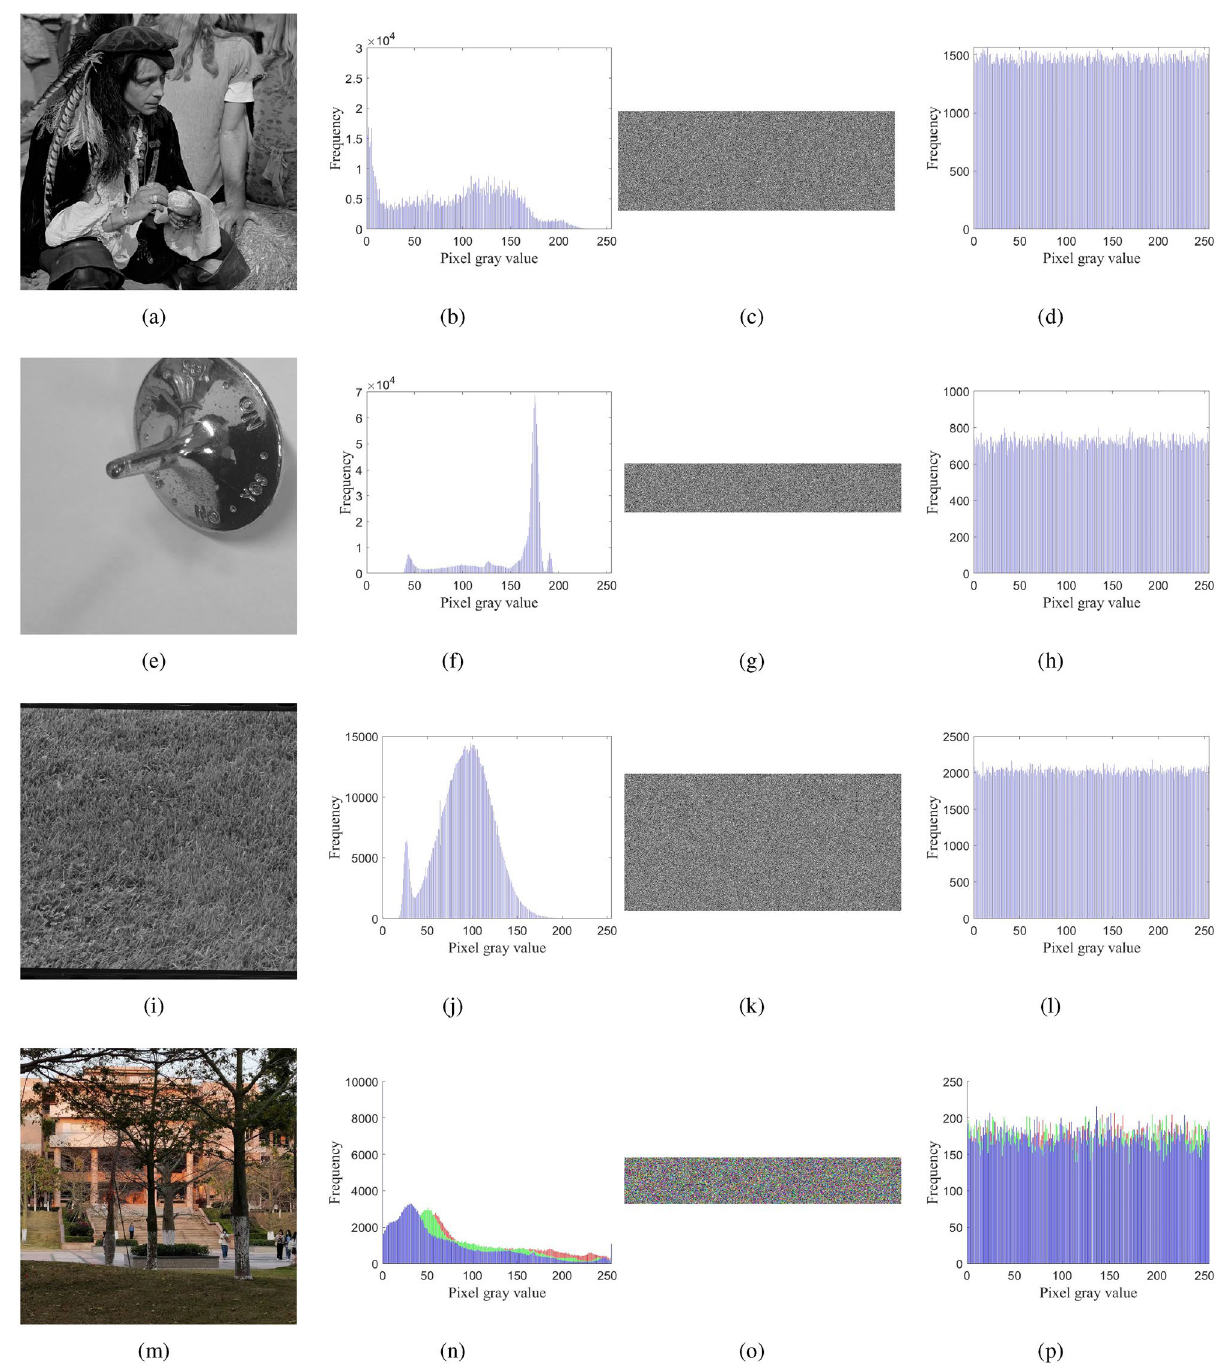
# 45 plain image; ( b ) the histogram of ( a ); # # plain image; ( f ) the histogram of ( e ); ( g ) 2 cipher image; ( h ) # 45 cipher image; ( l ) the histogram of ( k ); # cipher image; ( p ) the histogram of ( o